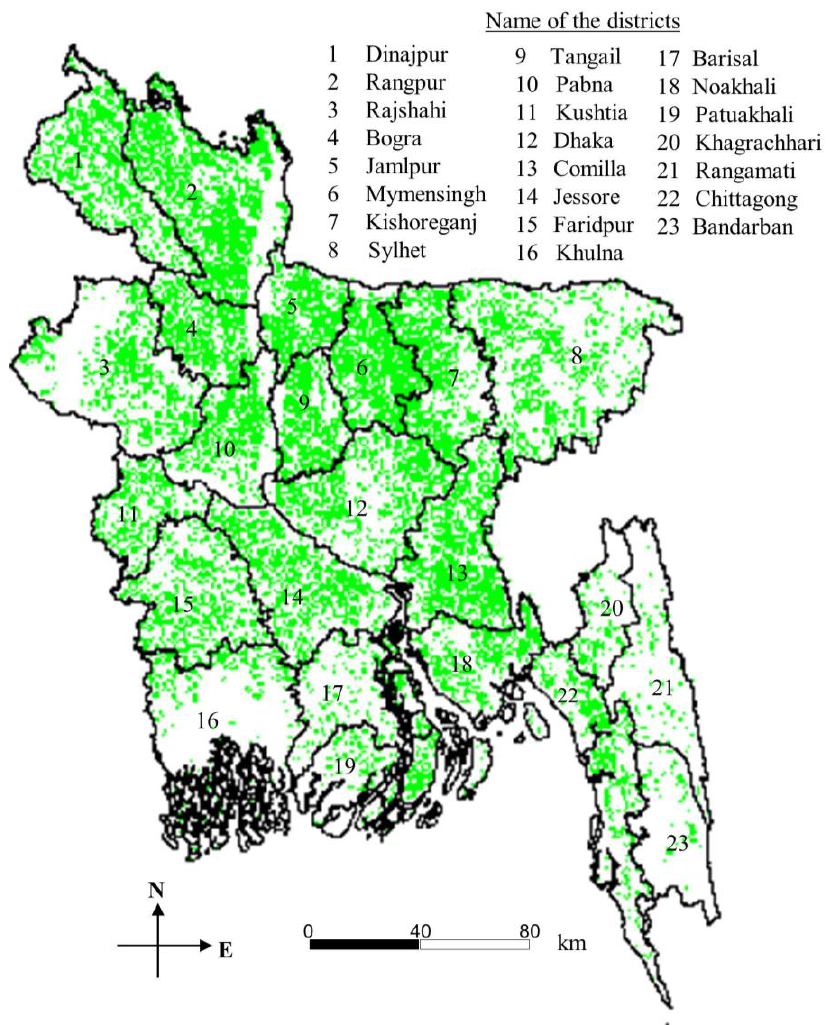
Figure 6. Example of MODIS-derived boro rice cultivation area (indicated using green shades) mapping during